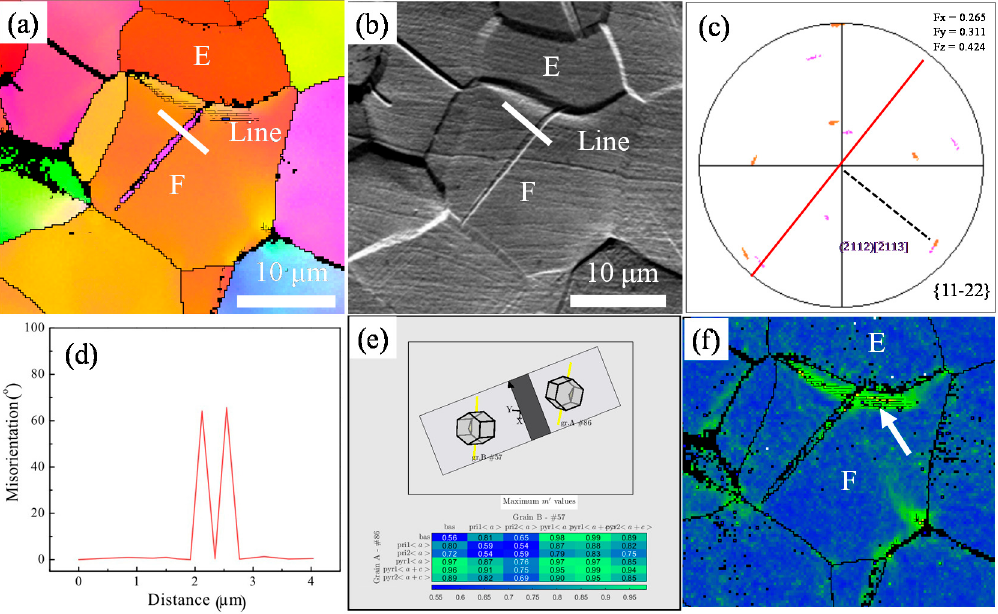
Figure 6. The nucleation of DT was induced by stress concentration at the GB: ( a ) IPF, ( b ) SEM, and ( c ) PF of 1122 ; ( d ) the distribution of misorientation along the line in ( a , e ); the calculation of m (cid:48) between grains E and F; and ( f ) KAM map.